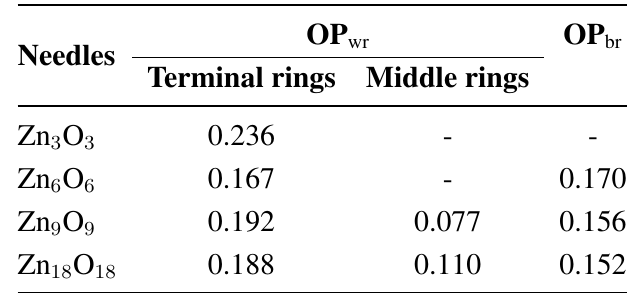
Table 1. Average overlap population values for Zn-O bonds within rings (OP rings (OP ) of needles of various lengths. A higher overlap population value indicates a br stronger bond. Zn-O overlap population within the ring drops upon growing the needle from a single Zn O ring, but the needle growth results in a positive overlap population between 3 3 Zn and O on adjacent